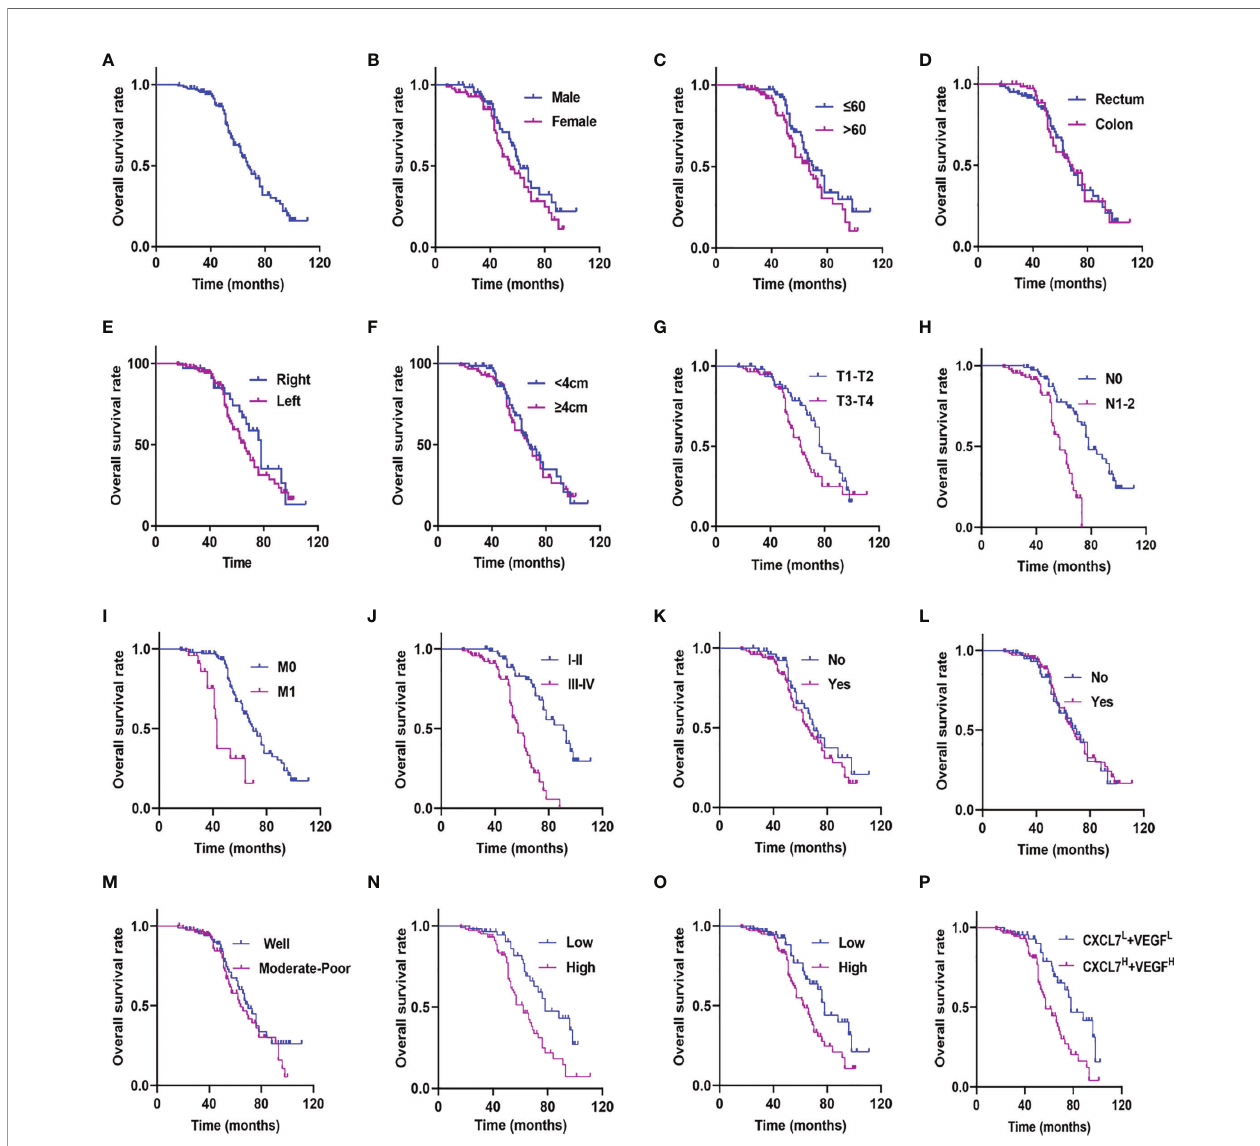
FIGURE 4 | Kaplan-Meier curves for CRC patients strati fi ed on the basis of CXCL7, VEGF and clinicopathological features. (A) OS in all 160 patients. (B) OS in male vs . female patients ( P = 0.133). (C) OS in age ≤ 60 vs . age >60 patients ( P = 0.117). (D) OS in colon vs . rectum patients ( P = 0.899). (E) OS in left side vs . right side patients ( P = 0.252). (F) OS in tumor size <4 cm vs . ≥ 4 cm patients ( P = 0.740). (G) OS in T1-T2 vs . T3-T4 patients ( P = 0.032). (H) OS in N0 vs . N1-N2 patients ( P < 0.001). (I) OS in M0 vs . M1 patients ( P < 0.001). (J) OS in I-II vs . III-IV patients ( P < 0.001). (K) OS in non- neural invasion vs . neural invasion patients ( P = 0.271). (L) OS in non-vascular invasion vs . vascular invasion patients ( P = 0.859). (M) OS in well differentiated vs . moderately-poorly differentiated patients ( P = 0.271). (N) OS in CXCL7 low expression (CXCL7 L ) vs . CXCL7 high expression (CXCL7 H ) patients ( P = 0.001). (O) OS in VEGF low expression (VEGF L ) vs . VEGF high expression (VEGF H ) patients ( P = 0.008). (P) OS in CXCL7 H + VEGF H vs . CXCL7 L +VEGF L patients ( P =